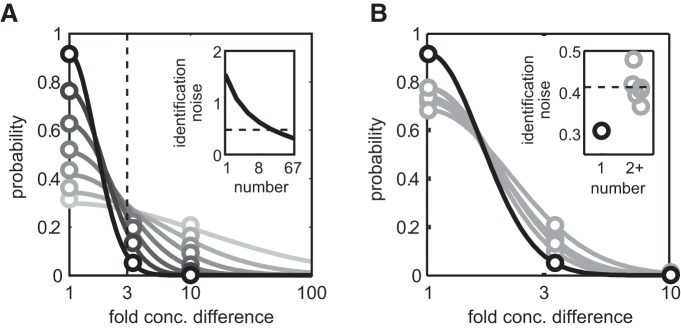
Adaptation increases concentration identification error. A, Results of classification analysis for concentration discrimination between four levels (0.0, 0.1, 0.3, 1.0): average probability of classification (empty circles) of temporal patterns of MTCs at the first sniff as a function of concentration mismatch between actual concentration and classified concentration (1 corresponds to correct classification, 3(10) is the classification mismatch for 1(2) step threefold concentration differences) for different numbers of cells (shading from lightest to darkest corresponds to 1, 2, 4, 8, 16, 32, and 67 cells). Solid lines are Gaussian fits of classification probability: p=p1exp-Δlog10C2/σ2, where p1 is a probability of correct classification, and σ is the concentration classification error in log10 units. Inset, Concentration classification error as a function of number of cells included in classification. Vertical dashed line: threefold concentration difference. B, Classification performance for all 67 cells for different sniffs following odor onset (black, sniff 1; gray, sniffs 2-7). Inset: concentration classification error for sniff 1 (black) vs later sniffs (gray). Dashed line: median for sniffs 2+.